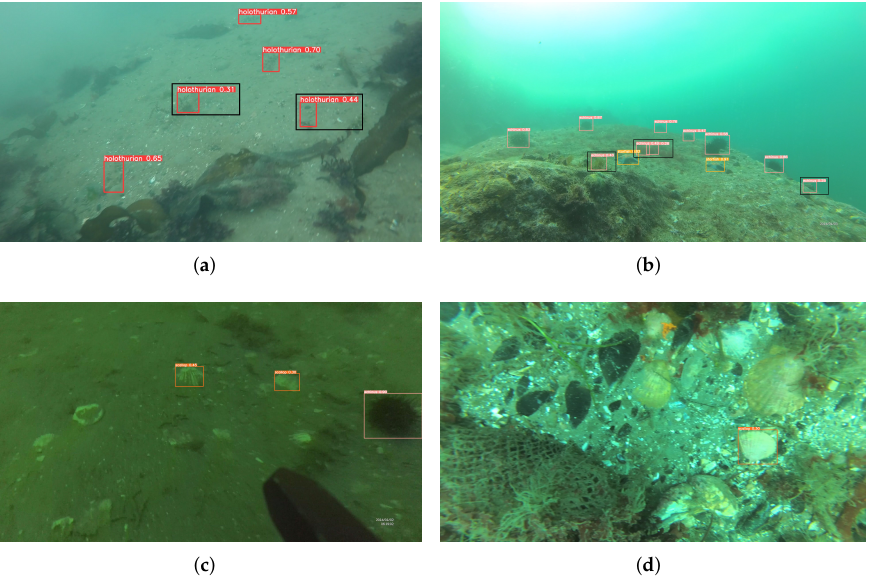
Figure 14. Examples of incorrect detection, where different color squares represent different tar- gets, the red squares represent holothurian, the pink squares represent echinus, the yellow squares represent starfish, the orange squares represent scallop: ( a , b ) examples of incorrect detection; ( c , d ) examples of not detected